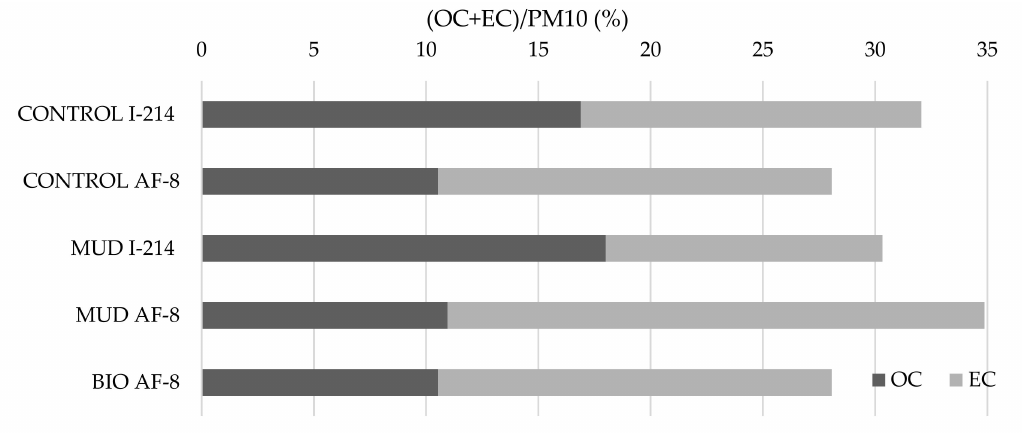
Figure 5. Carbon mass fraction in particulate